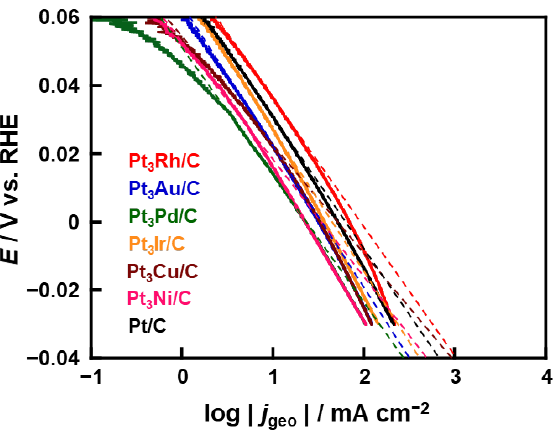
Figure 6. Tafel plots of activated Pt 3 M/C (M = Rh, Au, Pd, Ir, Cu and Ni)